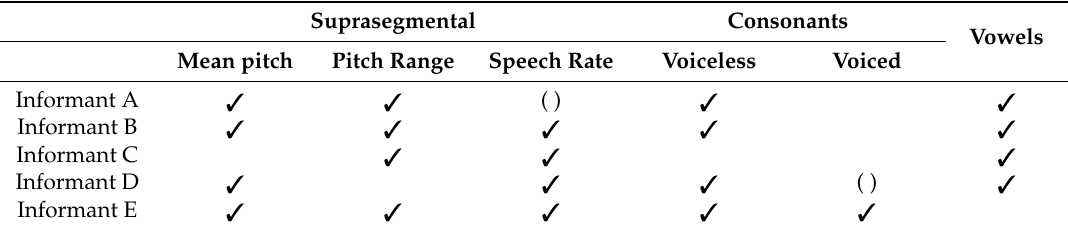
Table 8. Summary of significant e ff ects of TASK in our within-informant analyses. A check mark indicates significance at a p < 0.05 level, while ( ) points out a trending e ff